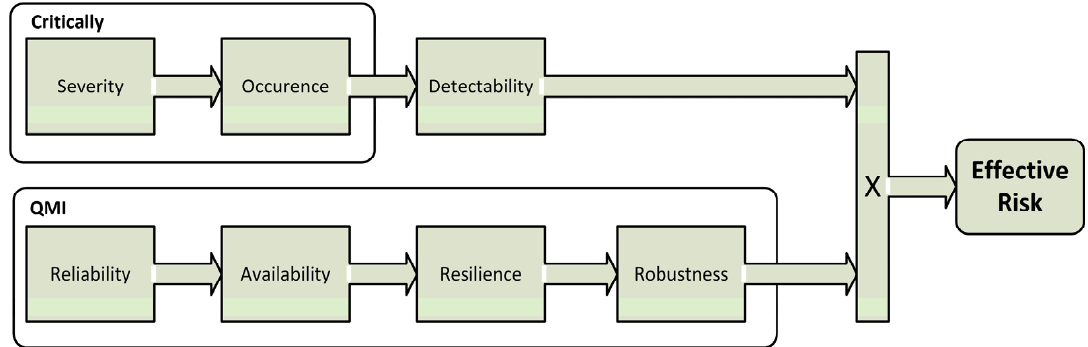
Figure 6. Conceptual representation of the effective risk model.